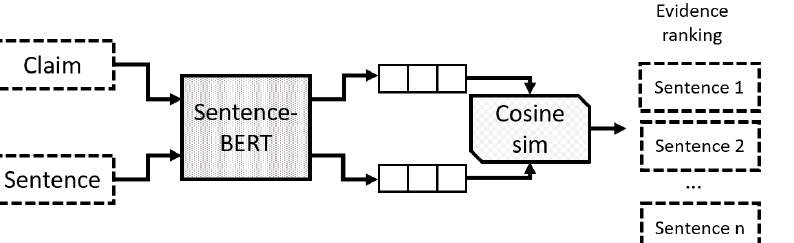
Figure 4. Baseline implemented with SentenceBERT [16] for the relevance evaluation task. The most similar sentences are retrieved.